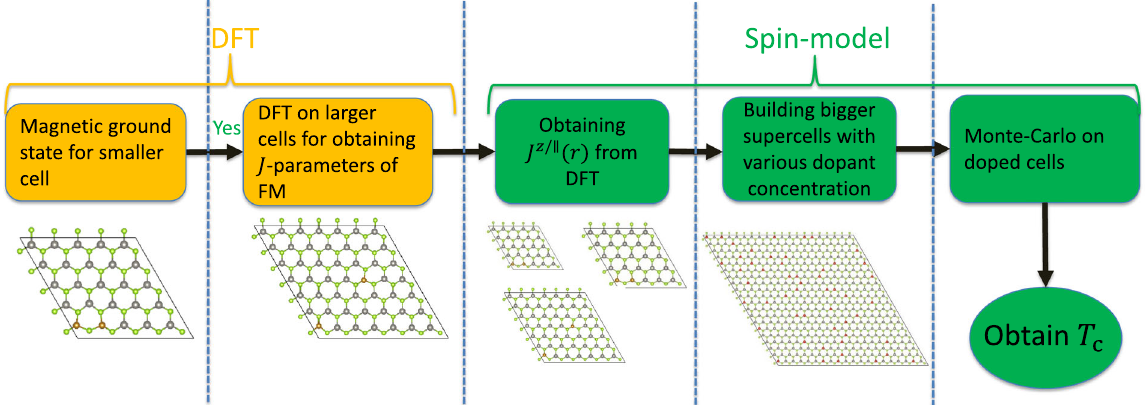
Fig. 1 Computational model for calculating the critical temperature. Different blocks show the different steps for calculating the critical temperature in substitutionally doped TMDs, combining DFT and the